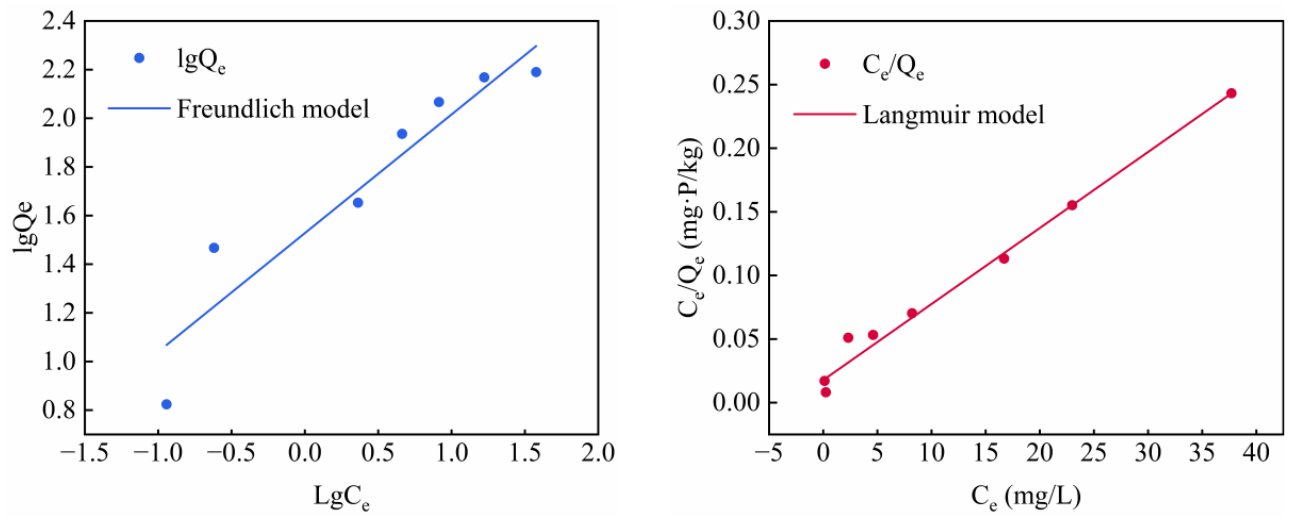
Figure 8. Langmuir and Freundlich models for the adsorption of phosphate onto ITs. Table 4. Parameters of the Langmuir and Freundlich isotherms for the adsorption of phosphate onto ITs. Langmuir